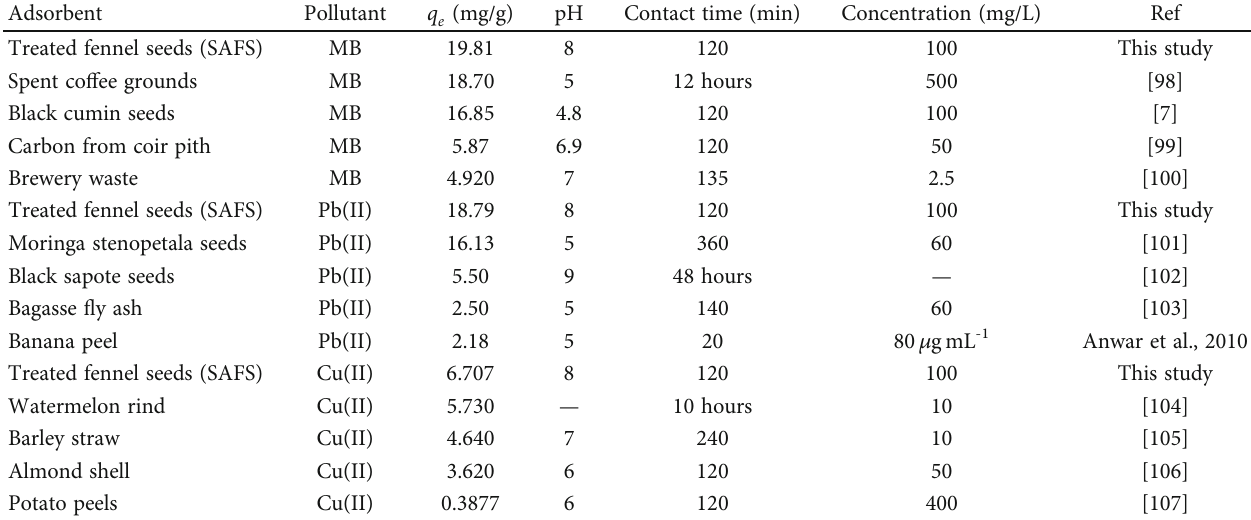
Table 7: Comparison studies of fennel seeds for the adsorption of MB, Cu(II), and Pb(II) with other agriculture biomaterials.